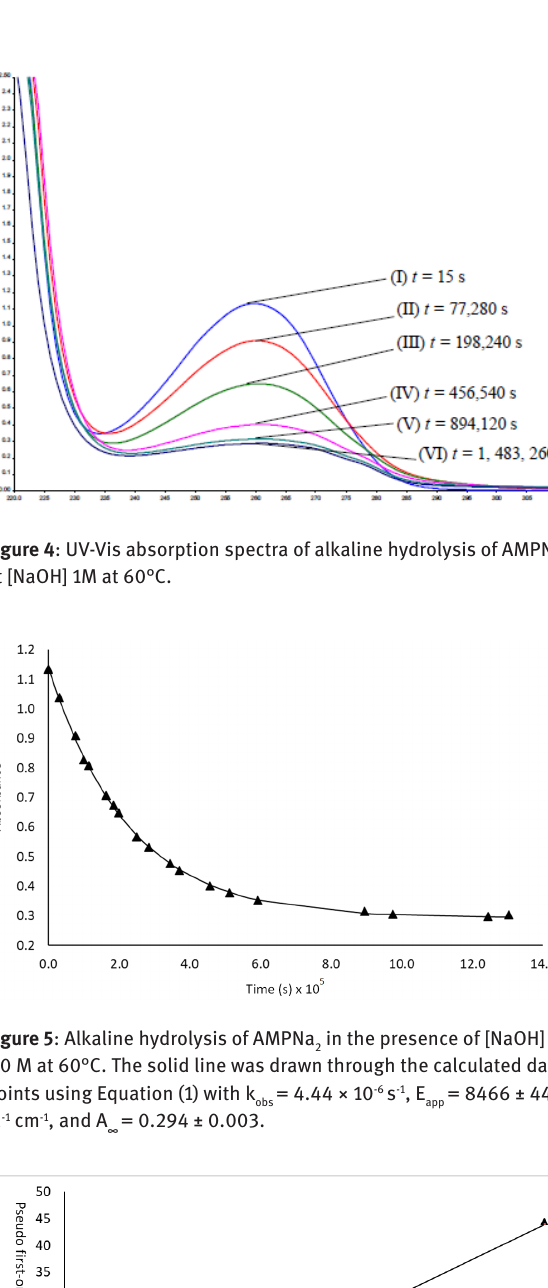
Figure 6: Pseudo-first-order rate constant, k alkaline hydrolysis of 0.0001M AMPNa drawn through the calculated data points using Equation